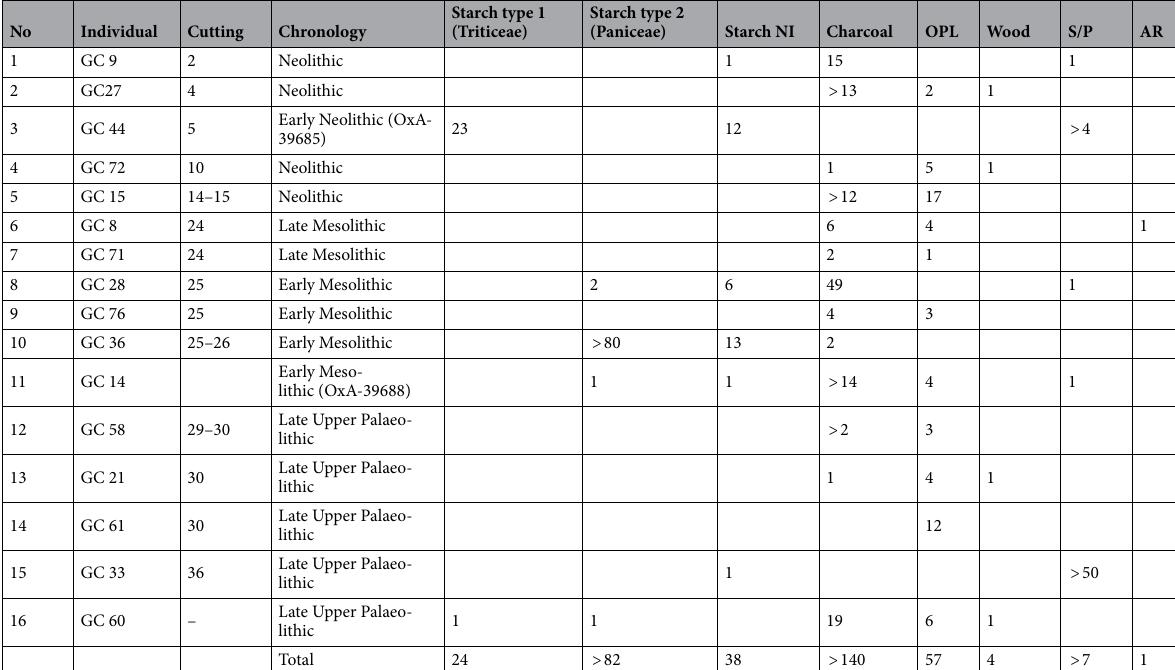
Table 2. Micro-debris retrieved in the dental calculus samples from Grotta Continenza. Starch Type 1 (Triticeae); Starch Type 2 (Paniceae); Starch NI starch not identified, OPL other plant remains: fibres and vegetal tissues; S/P spores and pollen grains; AR animal remains; the symbol “ > ” is used when starch granules or other microbotanical fossils cannot easily be counted, for example when embedded in dental